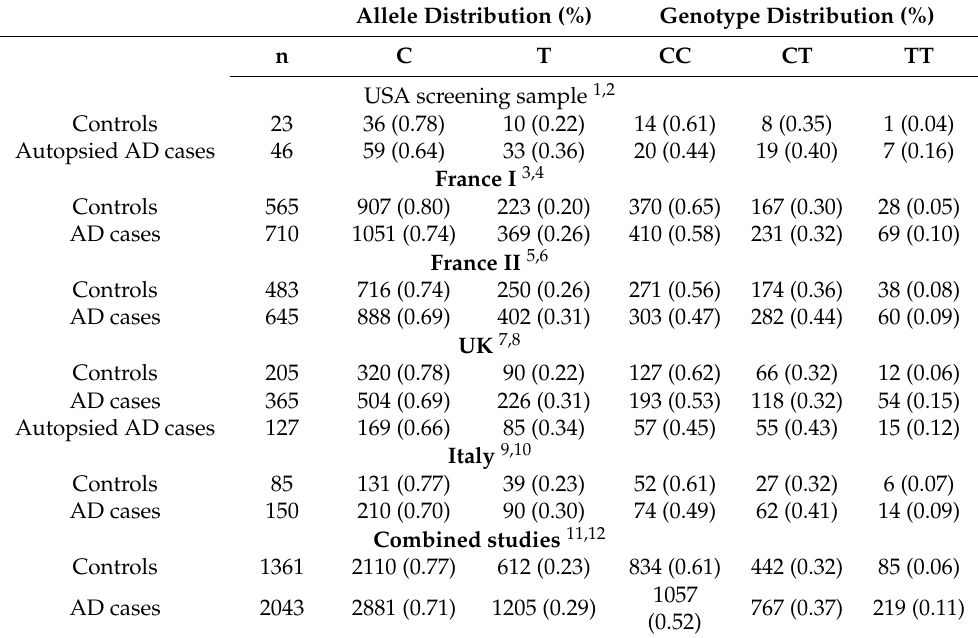
Table 8. Allele and genotype distributions of the CALHM1 P86L polymorphism (rs2986017) in AD case and control populations. Allele Distribution (%) Genotype Distribution